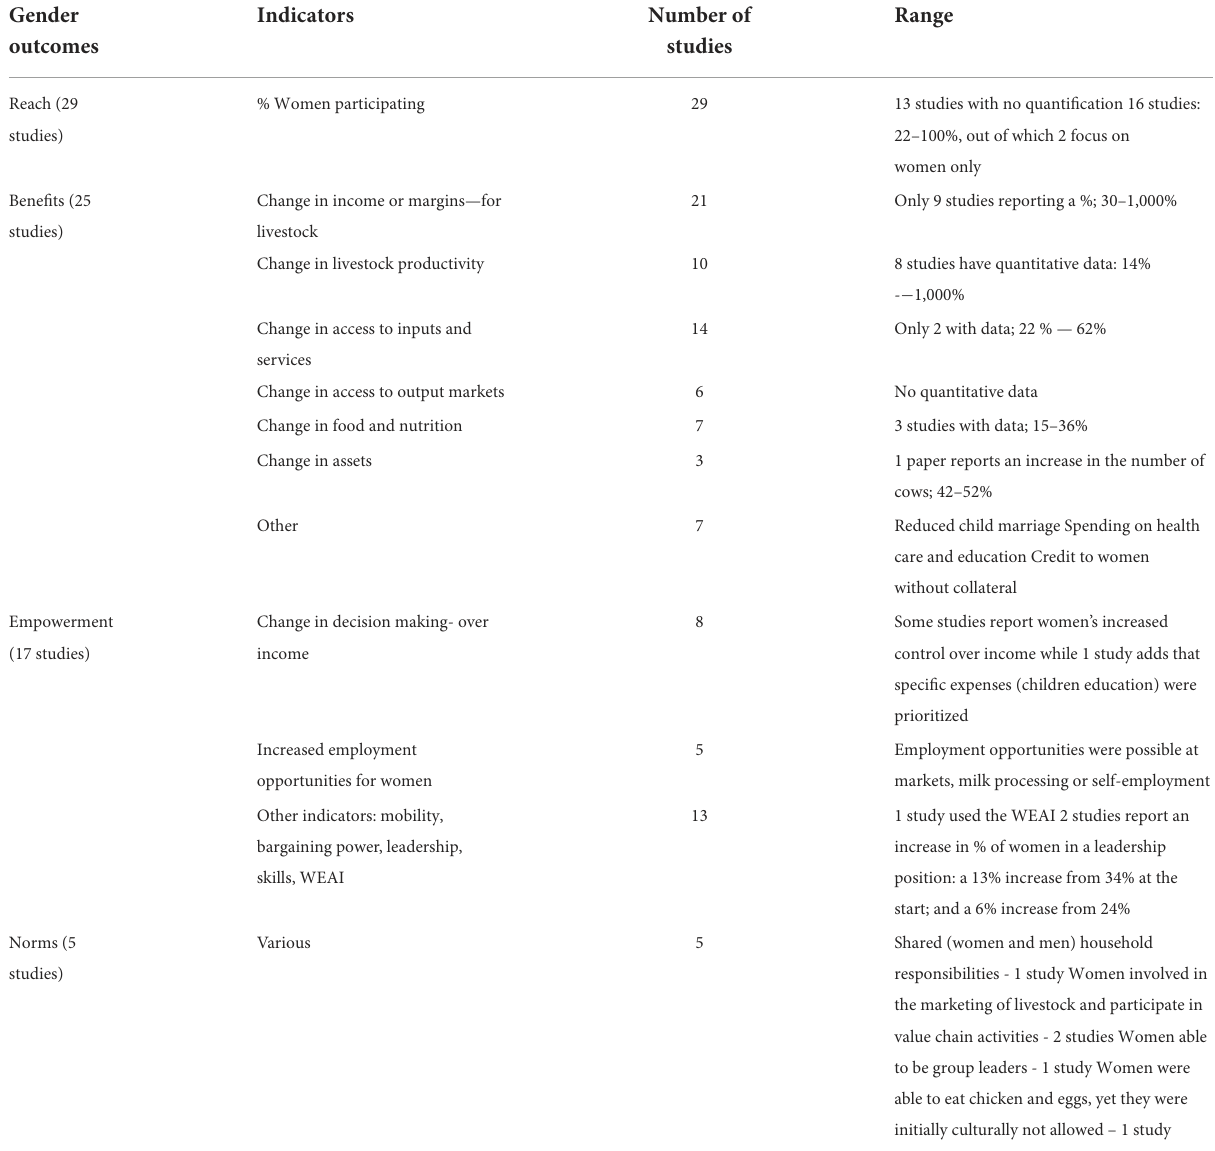
TABLE 3 Details on gender